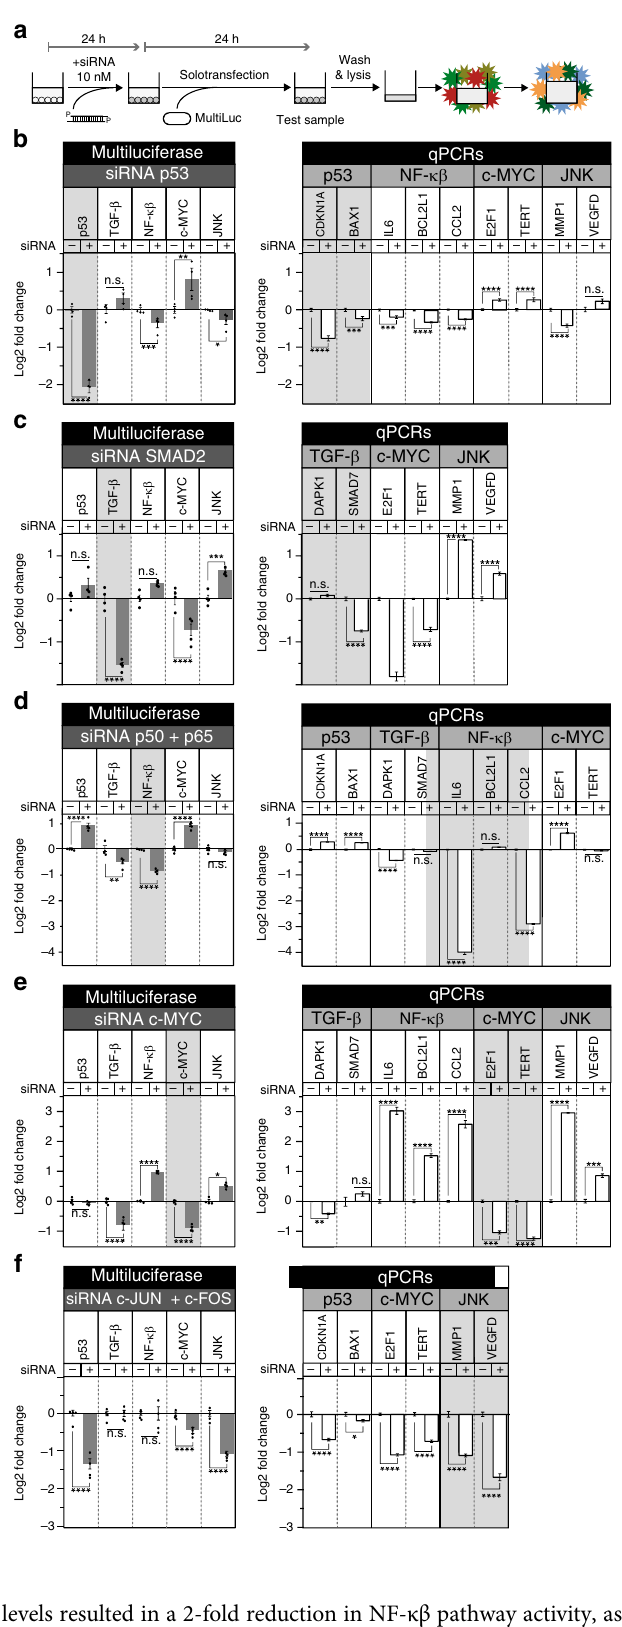
c-Myc pathway activities (1.3- and 0.5-fold, respectively) (Fig. 5f, left qPCR as MMP1 , CDKN1A , BAX1 , E2F1 , TERT , MMP1 and